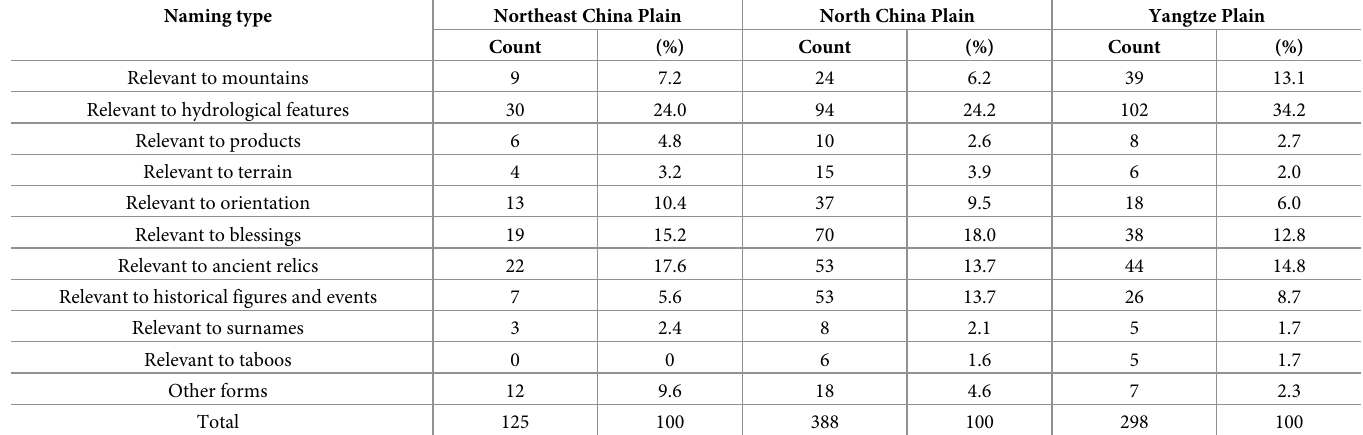
Table 2. Distribution characteristics of naming types of county-level administrative toponyms in 2010. Naming